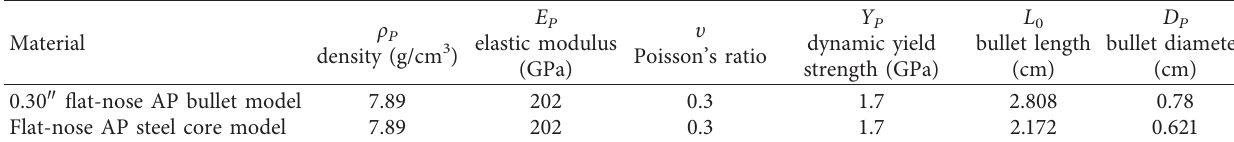
Table 4: Parameters of the material for AP models [9].